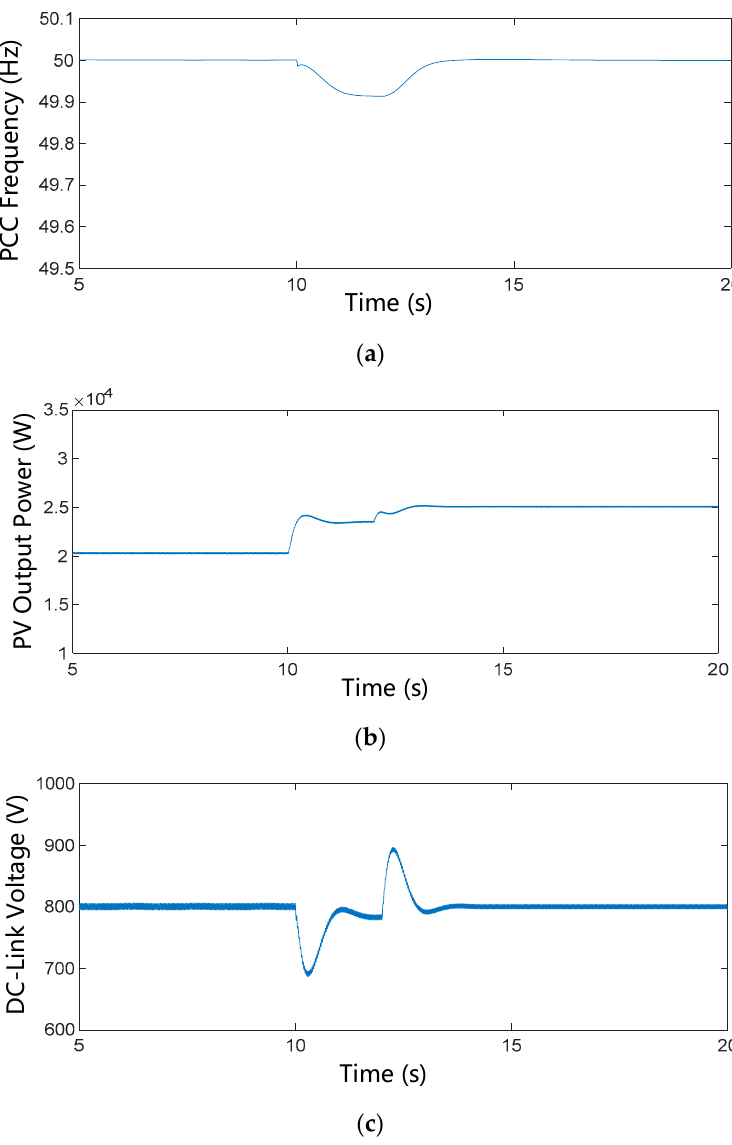
Figure 14. Simulation results of the proposed method under variable solar energy: ( a ) PV output power, ( b ) PCC frequency, ( c ) DC-link voltage.